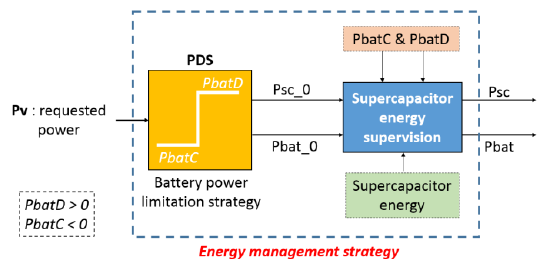
Figure 4. Energy management strategy schematic [32].